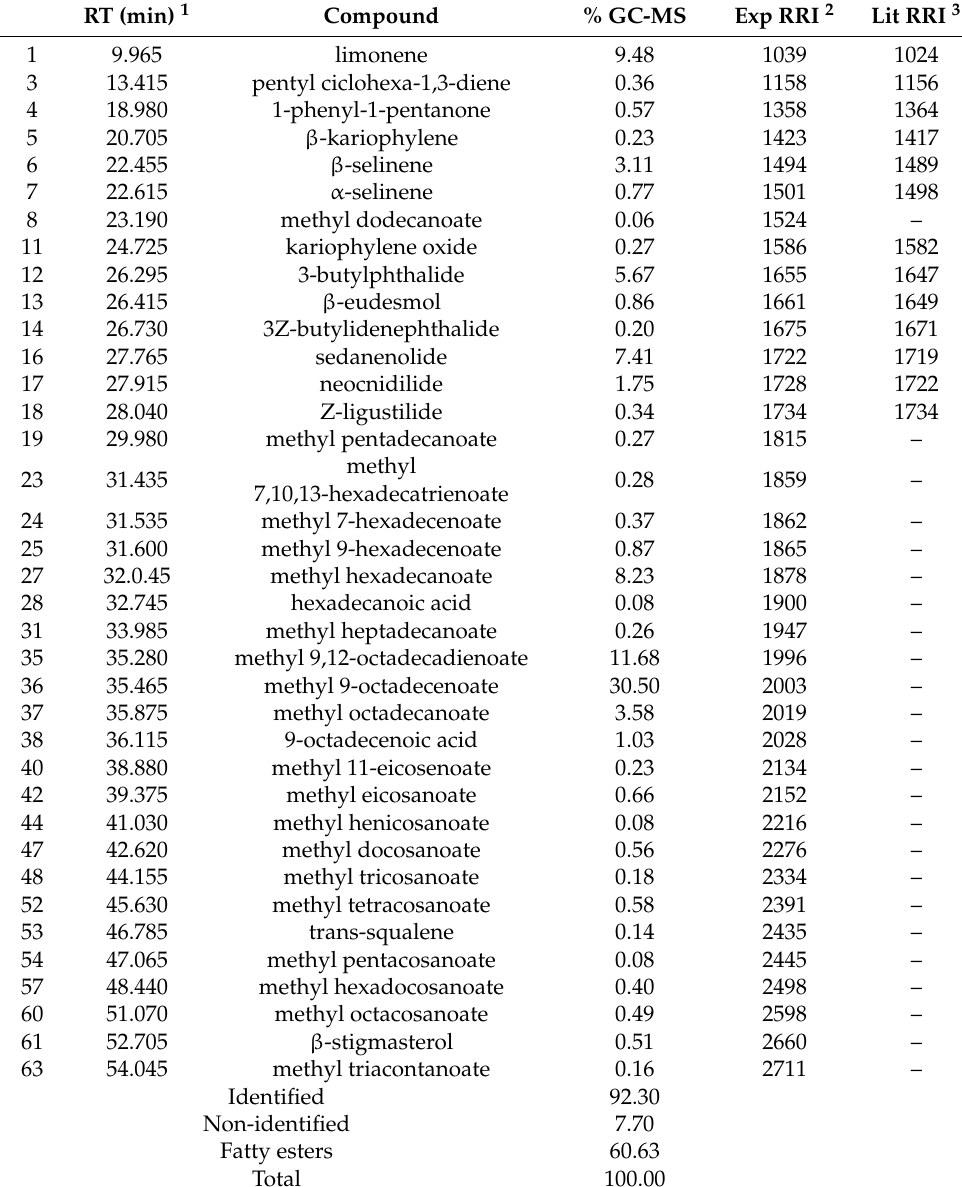
Table 1. Chemical composition of celery ( Apium graveolens ) oleoresin.